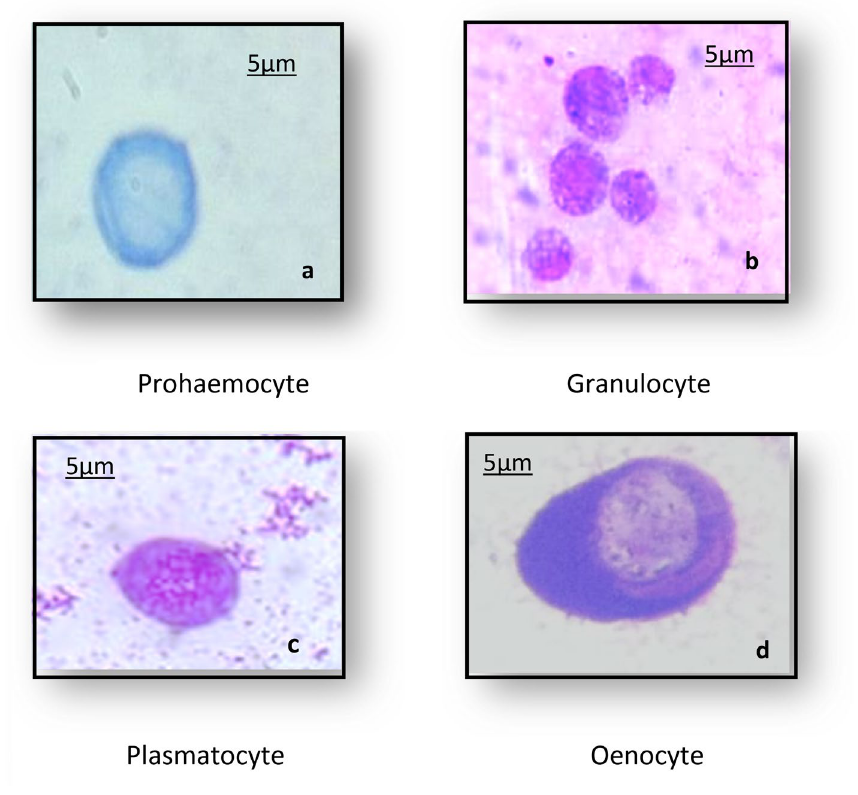
Figure 2. Hemocyte types of Bombyx mori larvae; ( a ) Prohemocyte (Prs) ( b ) Granulocyte (Grs) ( c ) Plasmatocyte(Pls) ( d ) Oenocytoid(Oes) (X100- oil; bar 5 μm) 2 .